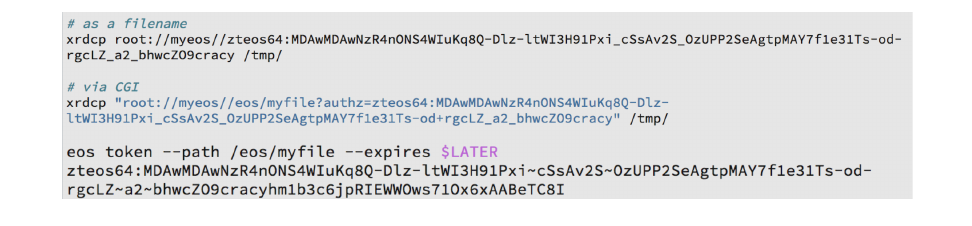
Figure 6. Usage and creation of an EOS